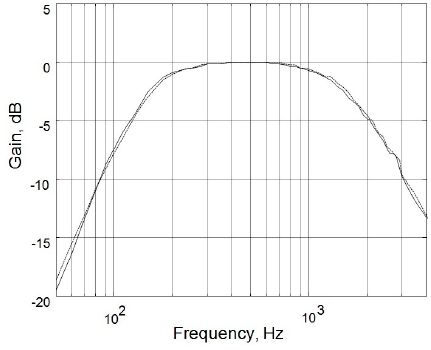
Figure 2. Each of the stethoscope head was made by encaving a condenser microphone into the bell taken from a conventional stethoscope.